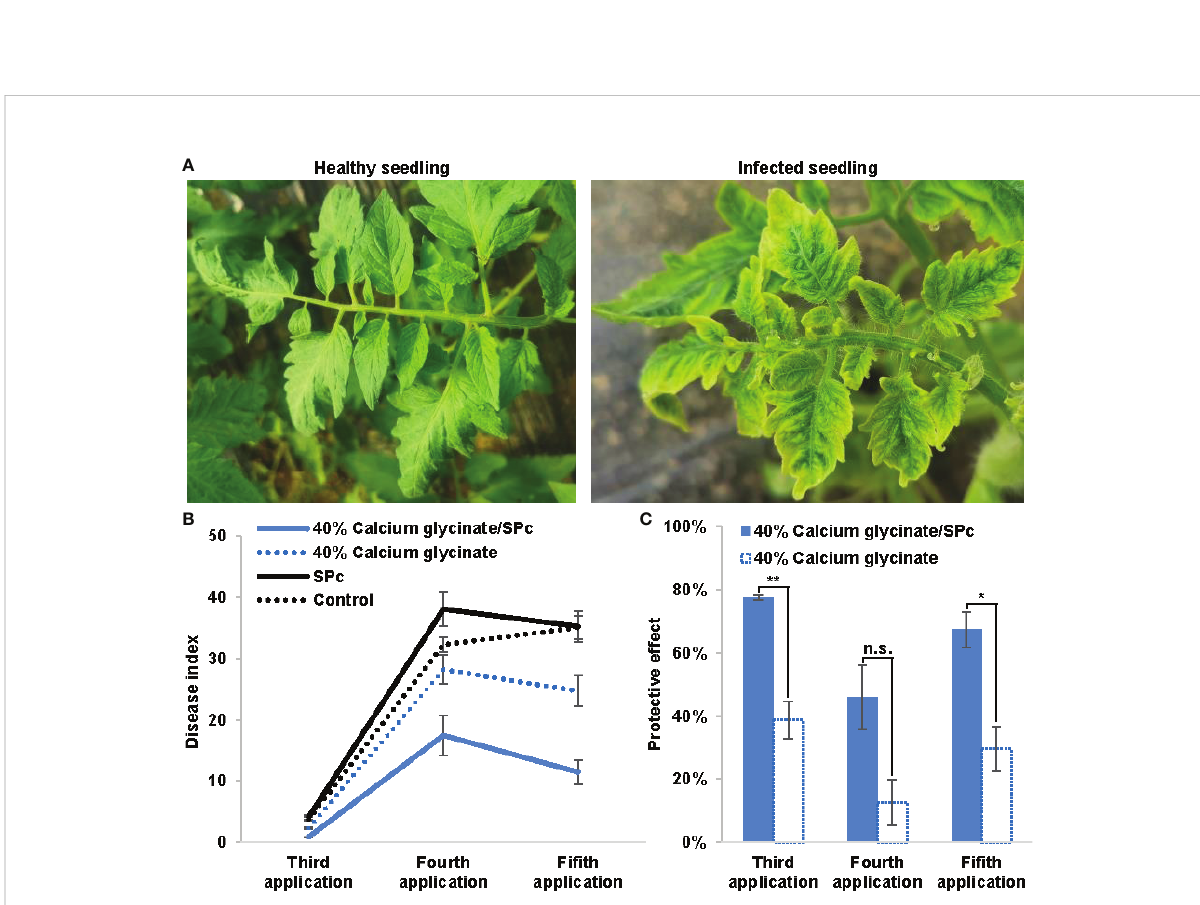
FIGURE 5 Enhanced bioactivity of SPc-loaded calcium glycinate toward tomato mosaic virus. (A) Photos of healthy and infected seedlings. (B) Disease indexes of seedlings were evaluated at 10 d post the third, fourth and fi fth applications, respectively. All seedlings from each plot were observed to record the disease grades. (C) Protective effect was assessed by disease index. The “ * ” and “ ** ” indicate signi fi cant differences (Independent t test, P < 0.05 and P < 0.01), and “ n.s. ” indicates no signi fi cant